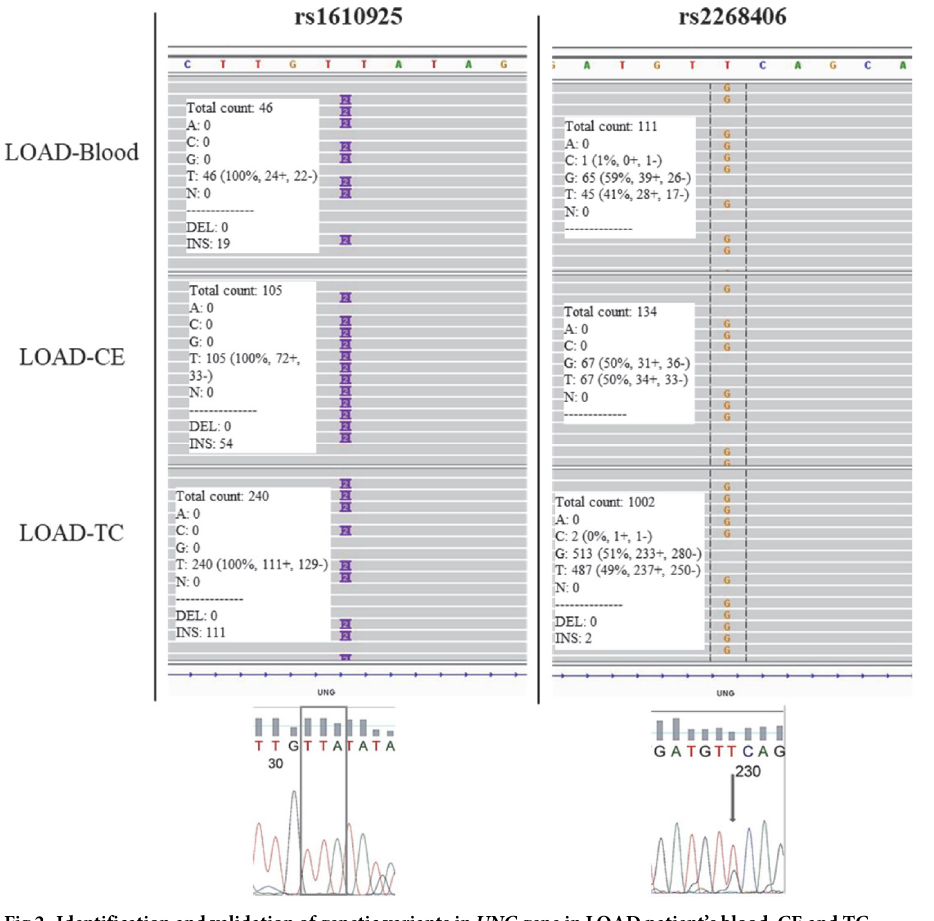
Fig 2. Identification and validation of genetic variants in UNG gene in LOAD patient’s blood, CE and TC samples. Targeted NGS results with corresponding Sanger sequencing validation of heterozygous variants UNG rs1610925 and rs2268406 in the blood of LOAD patients. NGS data are presented using the Integrative Genomics Viewer (IGV) software. Arrows and boxes indicate the position of the variant in the Sanger sequencing chromatograms. CE, cerebellum; TC, temporal cortex.